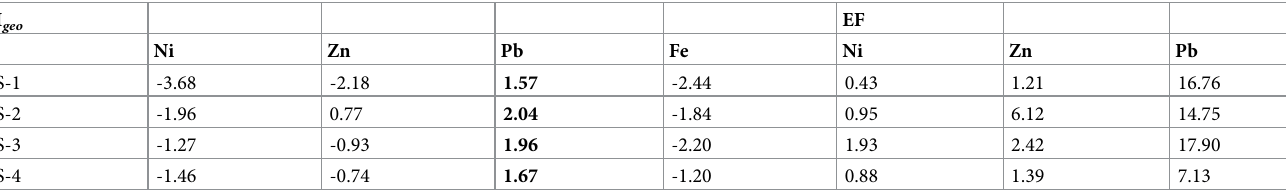
) and Enrichment factor (EF) of different metals in river sediments. geo